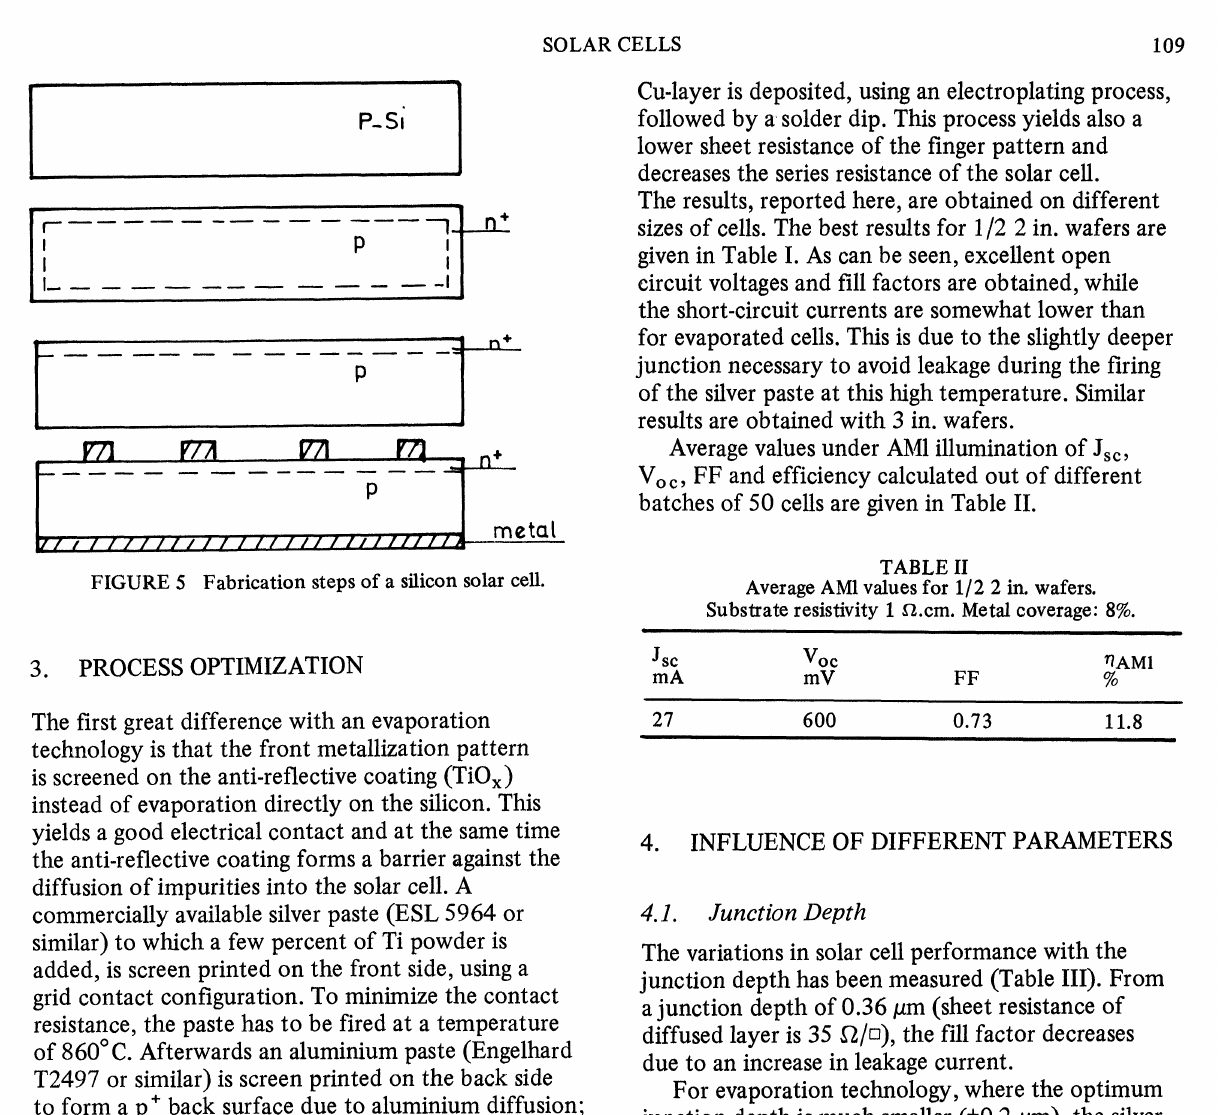
TABLE III Variations of fill factor in function of junction